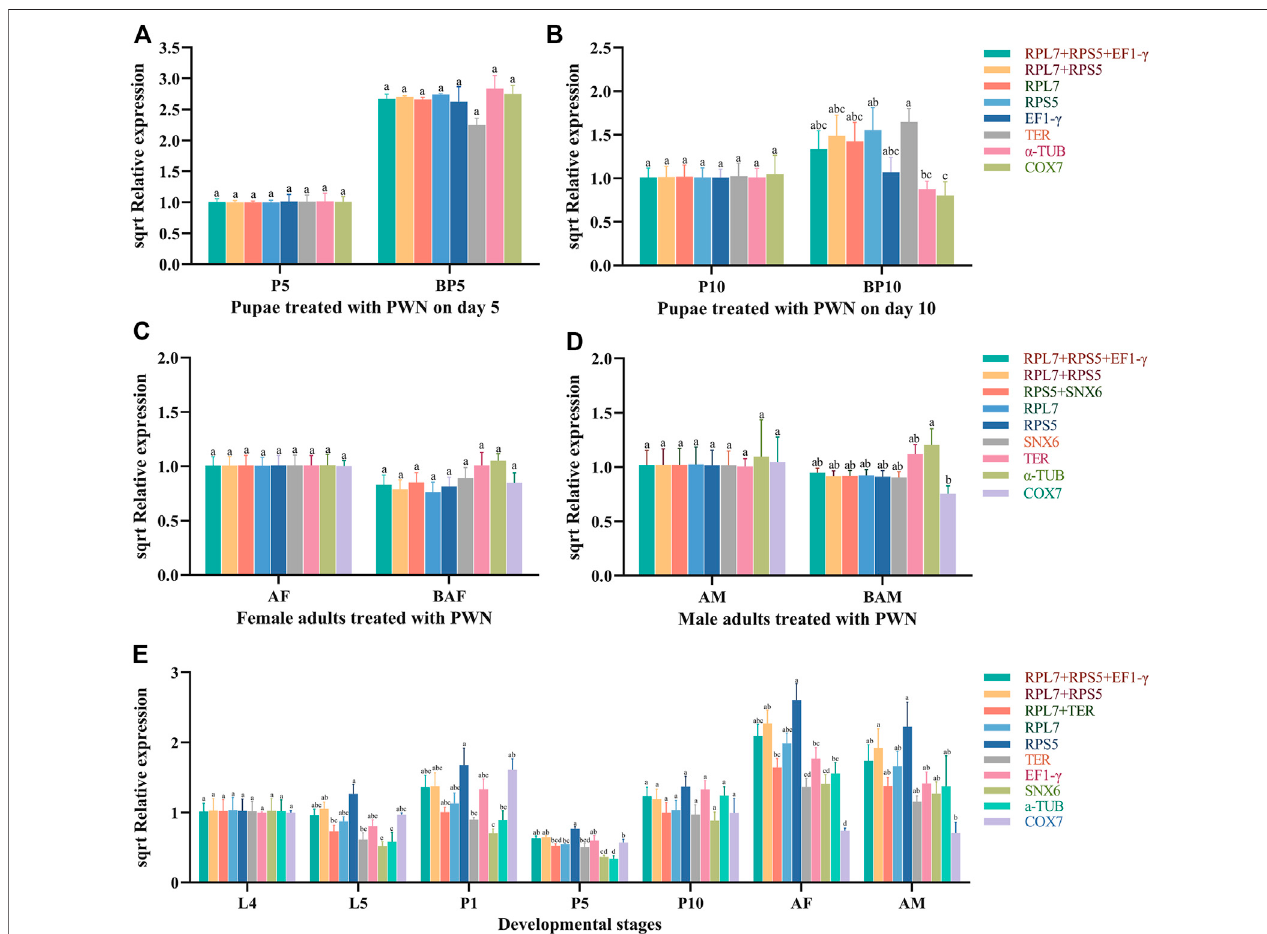
FIGURE5| Relative expression levelsof KLF normalized bycandidate reference genes. Differentletters indicate thesigni fi cantdifferences in KLF expression levels (ANOVA, HSD, p < 0.05).Sqrt (Relative expression)representsthe square rootof therelative expression value. (A) Pupae treated with PWN onday 5. (B) Pupae treated withPWNonday10. (C) FemaleadultstreatedwithPWN. (D) MaleadultstreatedwithPWN. (E) DevelopmentalstagesassociatedwithinfectionofPWNin M.saltuarius .